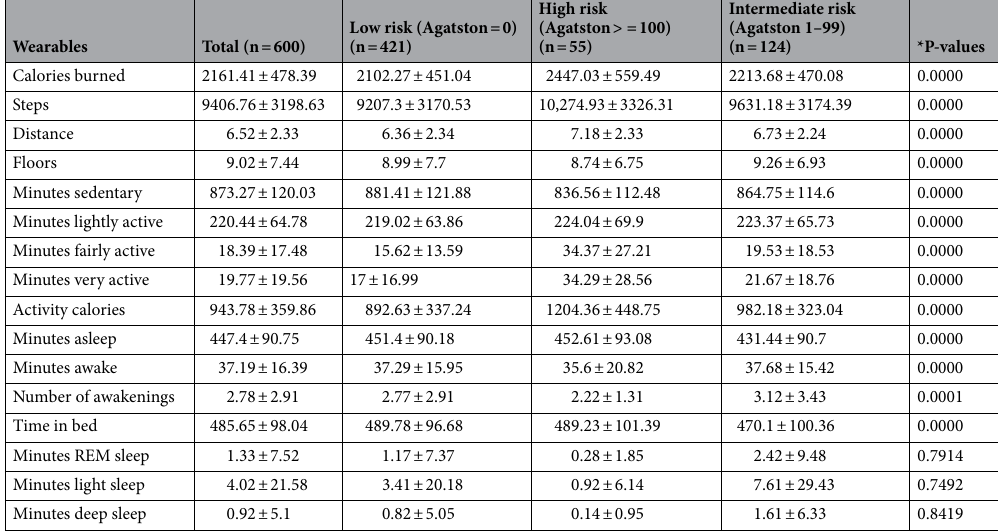
Table 5. Fitbit Charge HR data by risk categories. *Compares between low risk and high risk